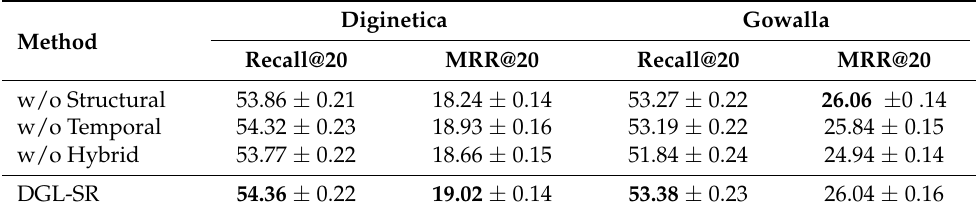
Table 4. Ablation